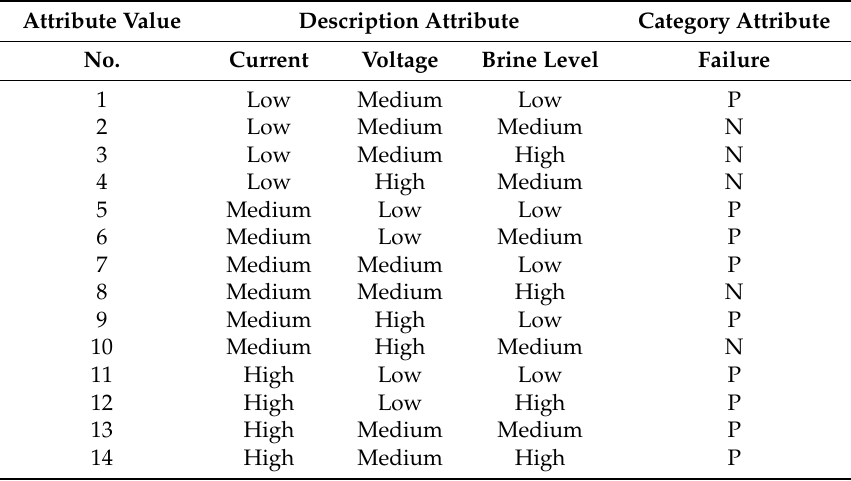
Table 8. Brine pump running status-training sample set